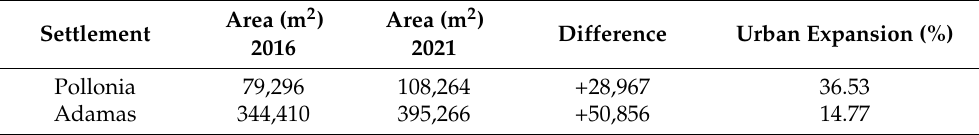
Table 7. Milos’s coastal settlements evolution for the time period